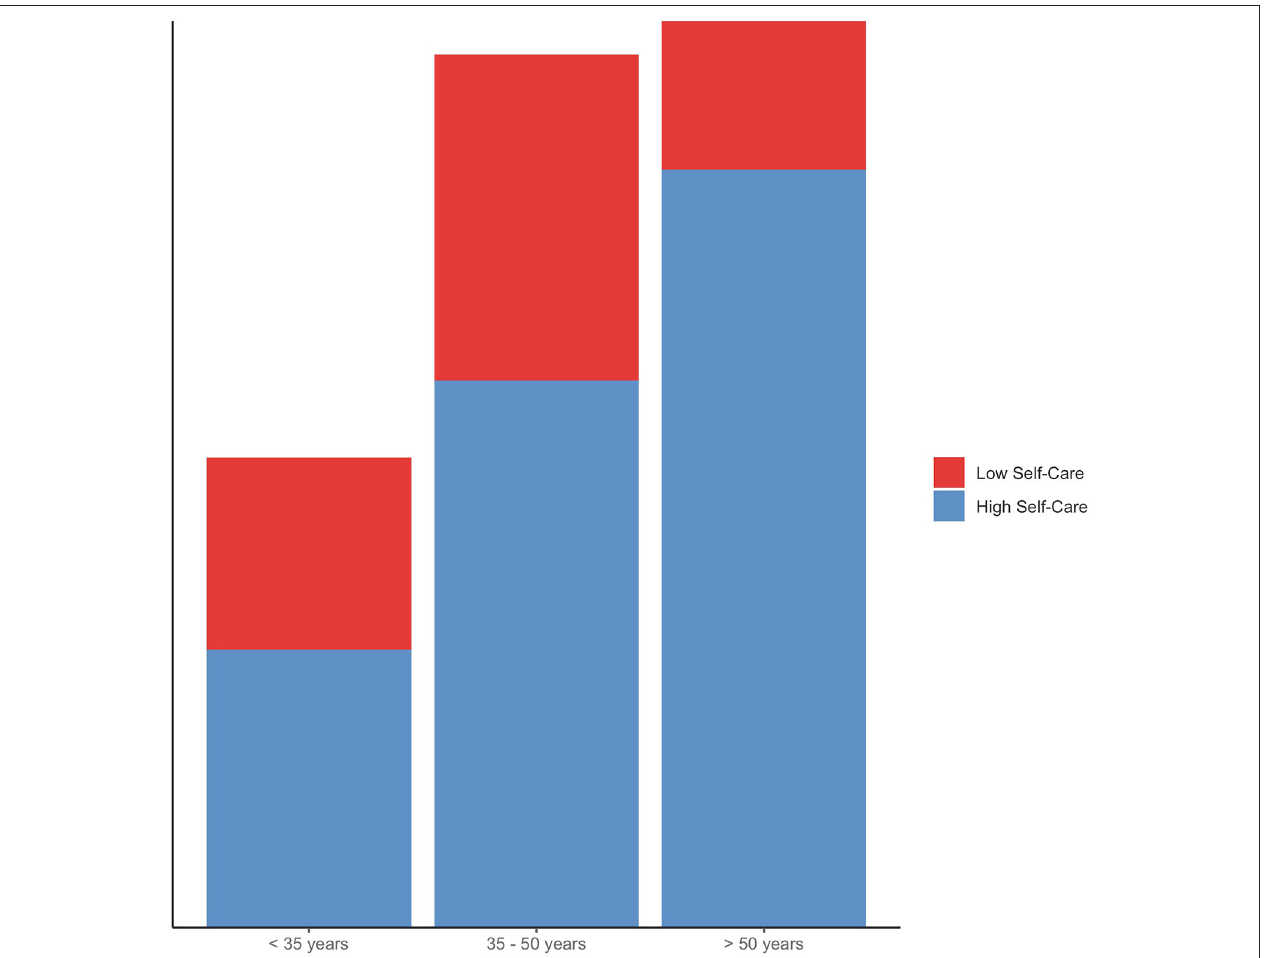
FIGURE 2 | Self-care by age group. High and low self-care categories were formed using a mean split.